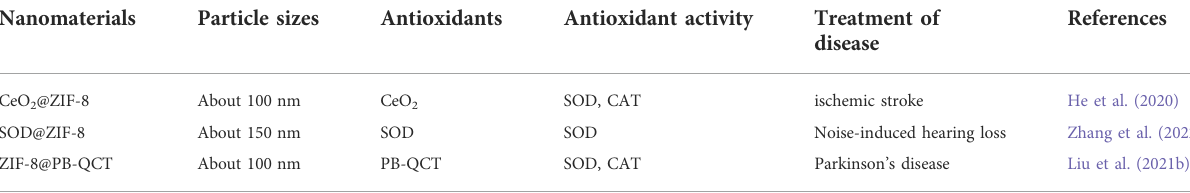
TABLE 1 Study on the diagnosis and treatment of oxidization-related diseases based on ZIF-8 nanomaterials.